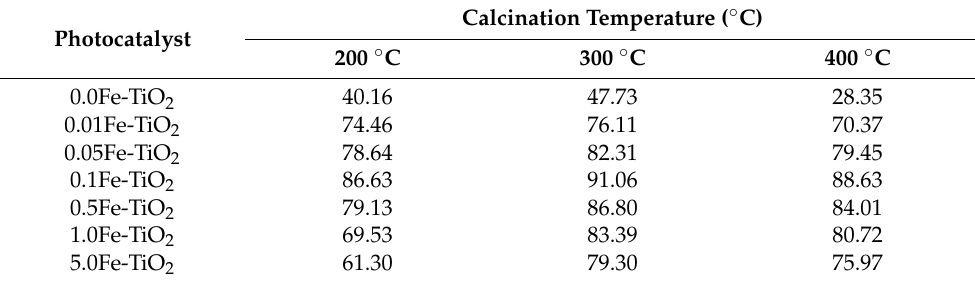
Table A1. Effect of calcination temperatures on RB5 decolorization for different Fe-TiO 2 loadings.